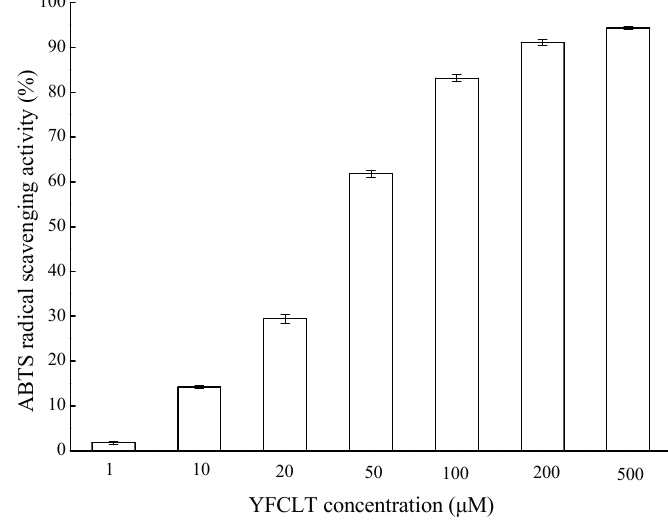
Figure 5. ABTS radical scavenging activity of peptide